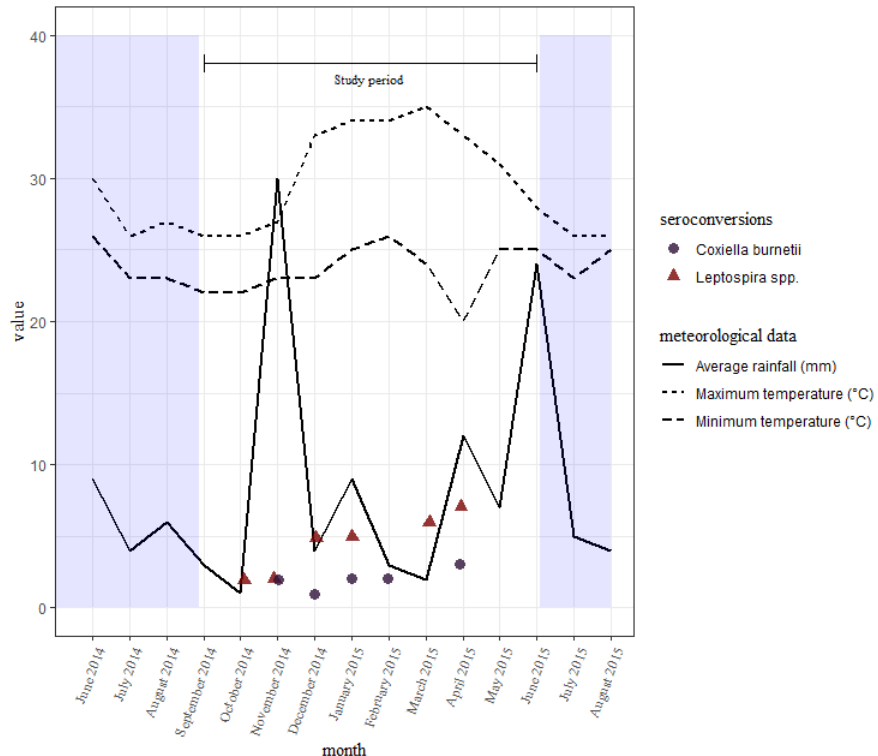
Figure 3. A distribution of seroconversions to Leptospira spp. and C. burnetii over time with the average rainfall received and temperatures reported every month in the study area. Sampling was done in September, November, and December of 2014, and in January, March, and June of 2015.